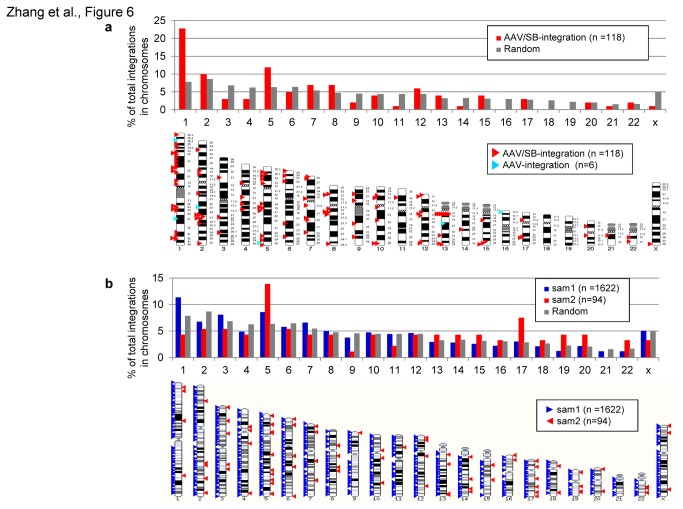
Integration sites from the hybrid AAV/SB vector system identified by plasmid rescue and LAM-PCR approaches.(a) Integration events identified by plasmid rescue. Percentages of integration events within each individual chromosome in comparison to a random control set is depicted in the upper panel. A schematic overview of chromosomal distribution is shown in the lower panel. The relative position of all unique integration sites identified from AAV/SB hybrid vector system infected cells were mapped within the human genome. Respective triangles indicate the relative positions of the chromosomal integration site observed (red triangle for SB-mediated integration; blue triangles for AAV -mediated integration).(b) Sequence reads and chromosomal distribution identified after performing LAM-PCR in AAV/SB hybrid-vector infected HeLa-cells (upper panel). Integration sites were compared to a computer-simulated random integration profile [13]. The lower panel shows mapping of all 1716 unique integration sites identified by LAM-PCR. Respective triangles indicate the relative positions of the chromosomal transposon integration site observed from sample 1 (blue triangles, AAV-neo MOI 10,000 and AAV-SB100X MOI 10,000) and sample 2 (red triangles, AAV-neo MOI 10,000 and AAV-SB100X MOI 50,000).